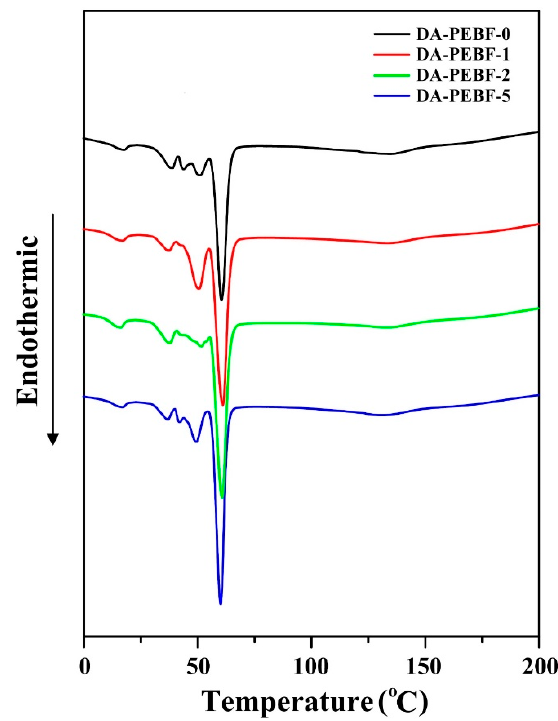
Figure 10. DSC profiles of DA-PEBF-0, DA-PEBF-1, DA-PEBF-2, and DA-PEBF-5 samples.